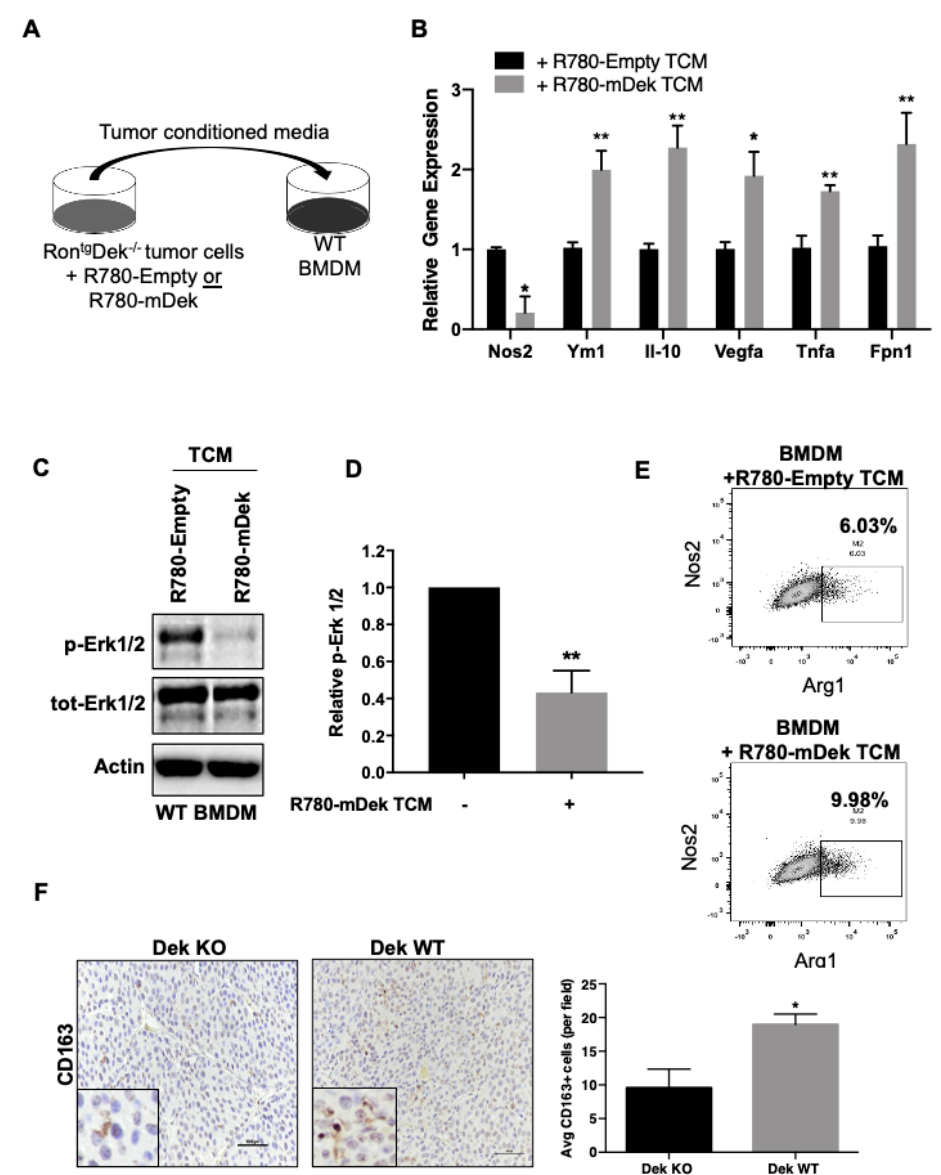
Figure 3. Bone marrow derived macrophages exposed to conditioned media from Dek-expressing breast cancer cells exhibit an M2 macrophage profile. ( A ) Schematic showing bone marrow derived macrophages (BMDM) from wild-type FVB/N mice were cultured in tumor conditioned media (TCM) from RD147 R780-Empty or R780-mDek cancer cells. ( B ) Quantitative RT-PCR shows down-regulation of the M1 marker Nos2 and upregulated mRNA expression of various M2 macrophage markers in BMDM exposed to TCM from Dek-expressing cancer cells (“R780-mDek TCM”). n = 3–6 biological replicates each with technical duplicates. ( C ) Phosphorylated ERK1/2 protein expression is downregulated in BMDM exposed to R780-mDek TCM as determined by Western blotting and the densitometry results are graphed in ( D ), n = 3. ( E ) Flow Cytometry was performed on BMDM cultured in R780-Empty or R780-mDek TCM to examine the expression levels of NOS2 (M1 macrophage marker) and ARG1 (M2 macrophage marker). Flow data shows that BMDM exposed to R780-mDek TCM have more Arg1 hi Nos2 lo cells (M2-like) compared to BMDM exposed to control Dek-deficient cells. ( F ) Immunohistochemical staining for CD163, an M2 specific macrophage polarization marker, shows a significant increase in the abundance of M2 macrophages in Dek WT tumors. The average number of positive CD163 cells were counted per field, as depicted in the graph on the right ( n = 3 tumors from independent mice / genotype). * indicates p -value is < 0.05 and ** indicates p -value is < 0.01 using Student’s t